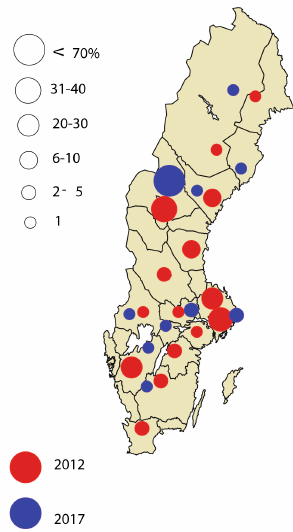
Figure 1. The geographic distribution of the informant’s current place of residence n = 217 1 . 1 The blue dots on the map describe the 2017 sample and the red dots describe the 2012 sample. Source: Own